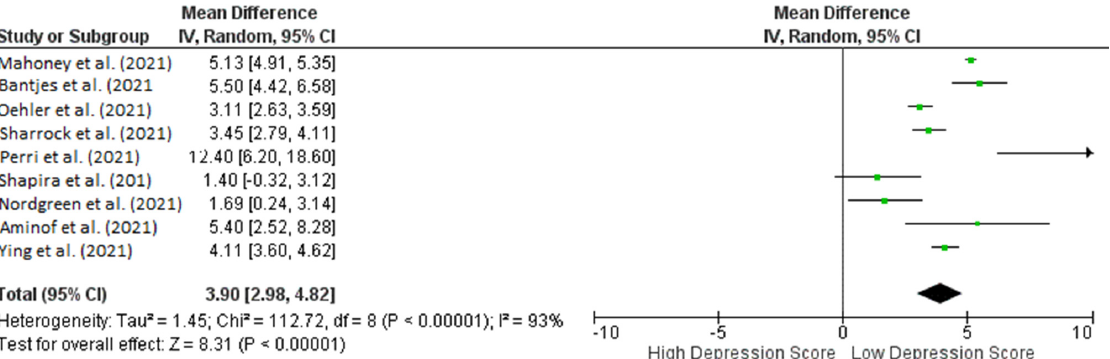
Figure 2. Forest plot pre- and post-intervention of ICBT in achieving low depression scores in depression patients during COVID-19 pandemic.